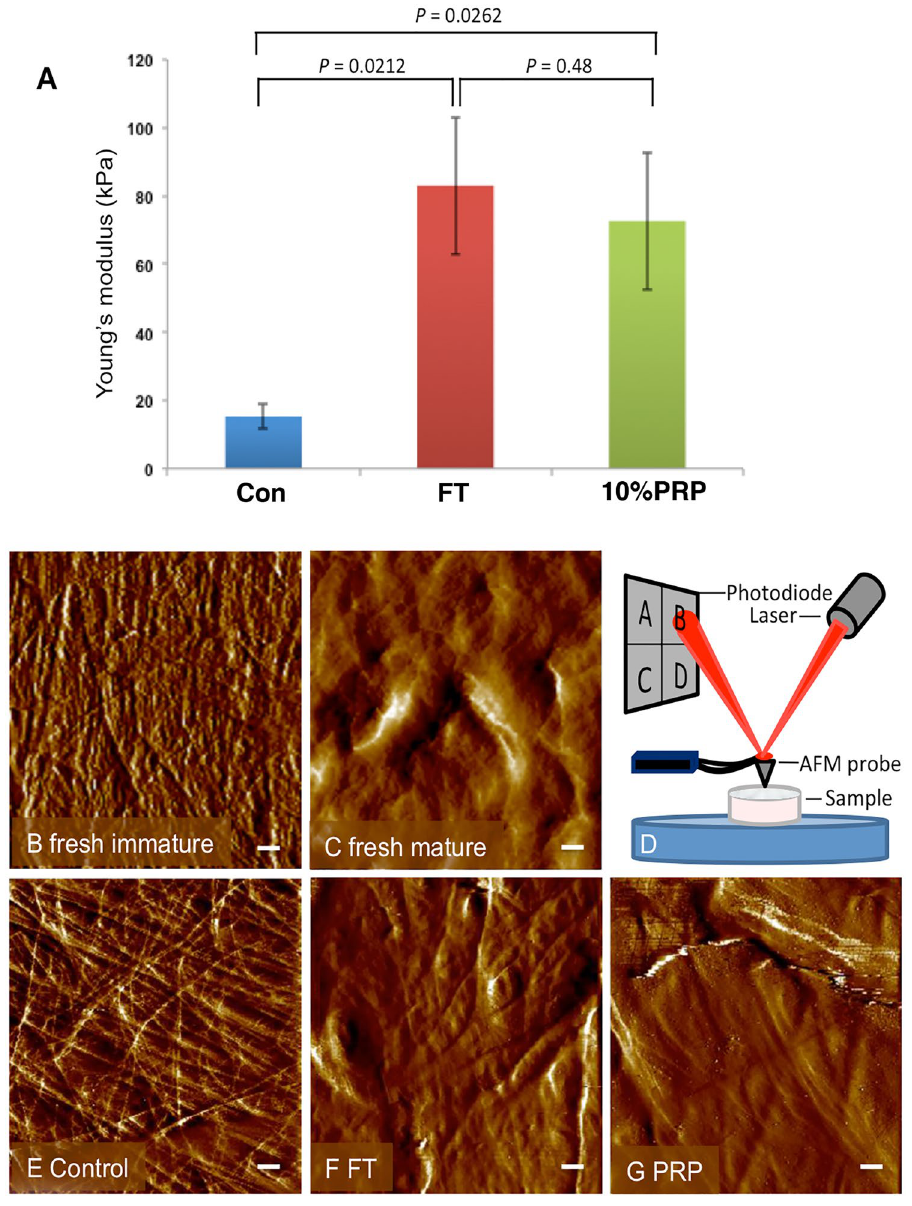
Figure 3. AFM analysis of the effect of PRP on cartilage stiffness and surface topology. Graph showing the change in stiffness (Young’s modulus, kPa) following treatment of cartilage explants for 21 days in culture ( A ). Surface topography of freshly isolated immature ( B ) and mature ( C ) cartilage explant as reference. Ten per cent PRP lysate ( G ) and growth factor ( F ) treated explants cultured for 21 days exhibited surface profiles that were similar to mature cartilage ( C ), whereas untreated explants ( E ) were closer in profile to freshly isolated immature cartilage ( B ), scale bar equals 0.5 μ m. Diagram showing the experimental setup measuring cartilage biomechanical and topographical properties ( D ). The laser is deflected by the change in angle of the AFM probe and this deflection correlates with tissue biomechanical